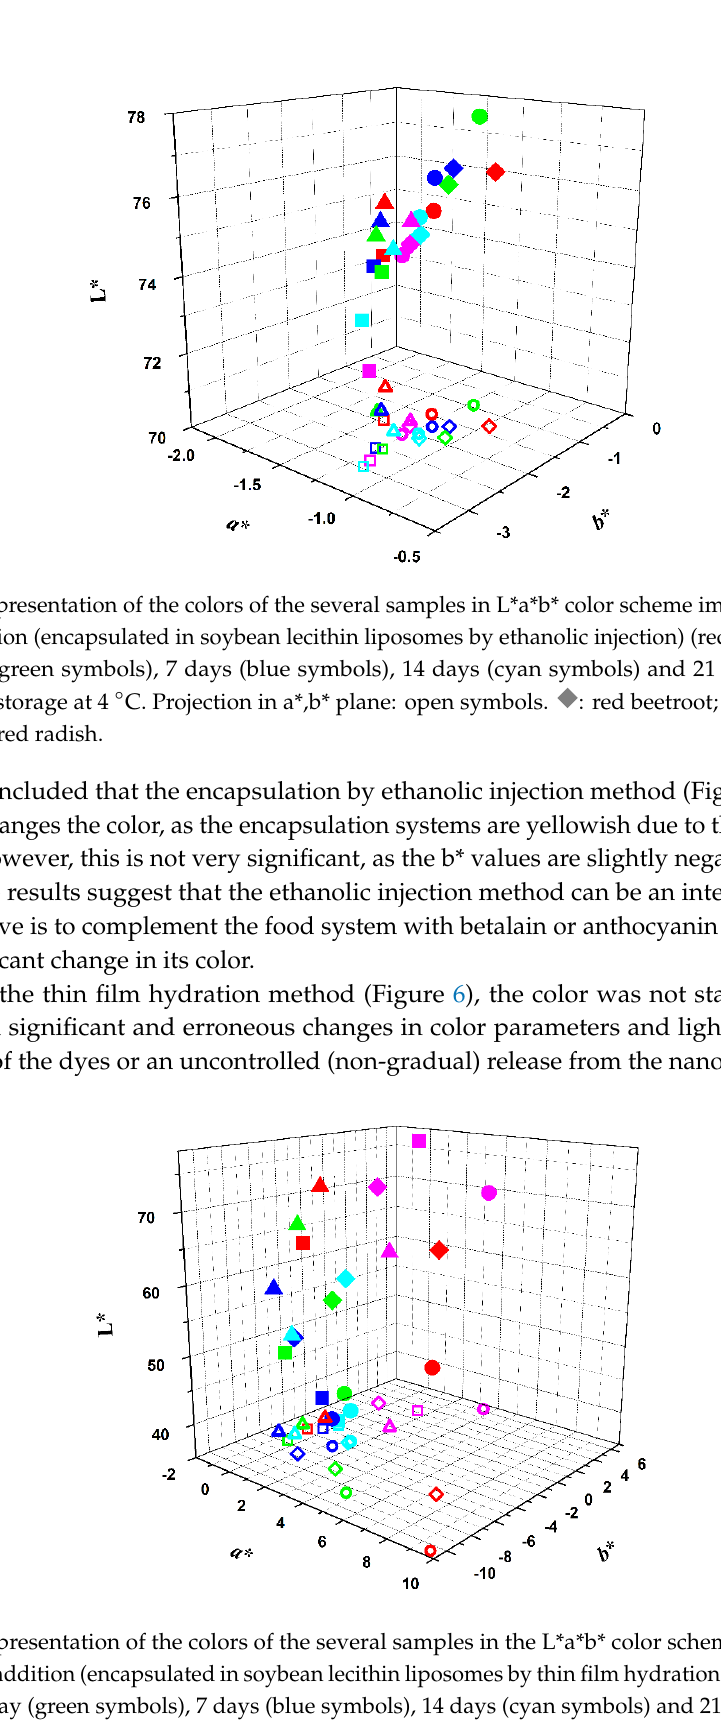
= red), and b* is the degree of yellowness and blueness (from −100 to 0 = blue; from 0 to +70 = yellow).